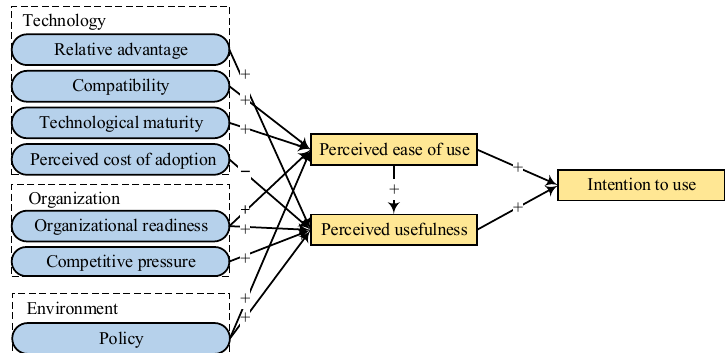
Figure 2. Blockchain adoption intention model.